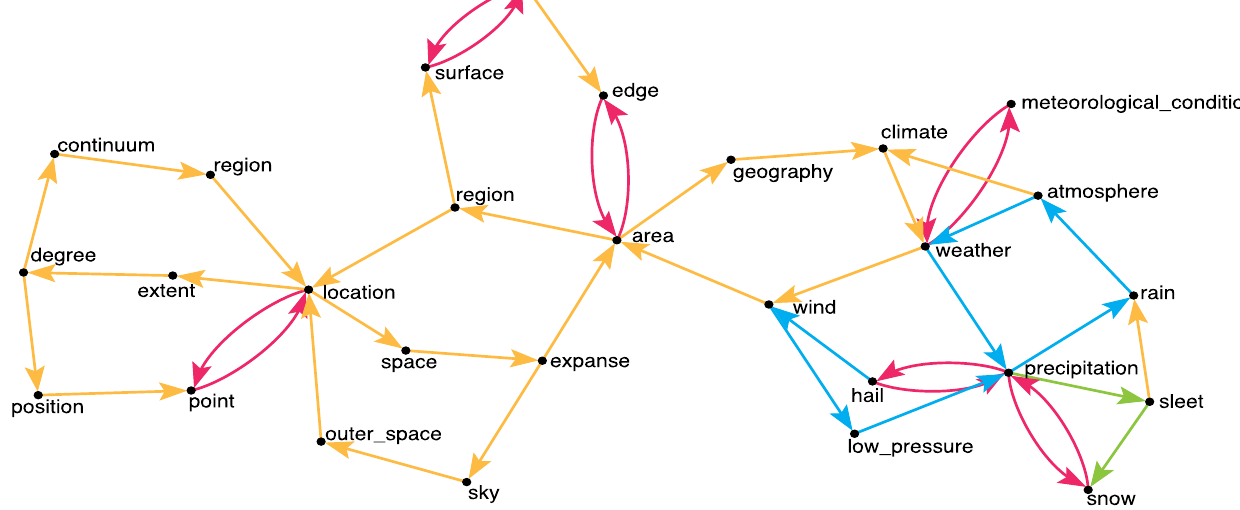
FIG. 5. An example of a large, strongly connected component in the decomposition. Arrows are drawn from a node to words in its definition. Red links appear first in two-loops, green in three-loops, blue in four-loops, and orange in